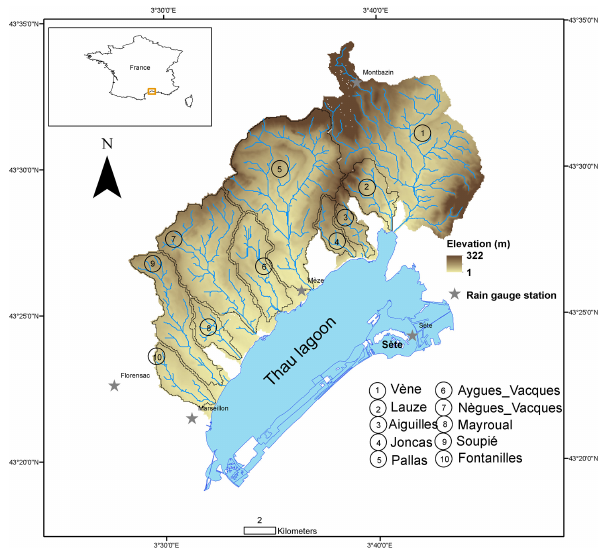
Figure 1. Location, topography, rain gauge stations and subcatch- ment boundaries of the Thau Basin.